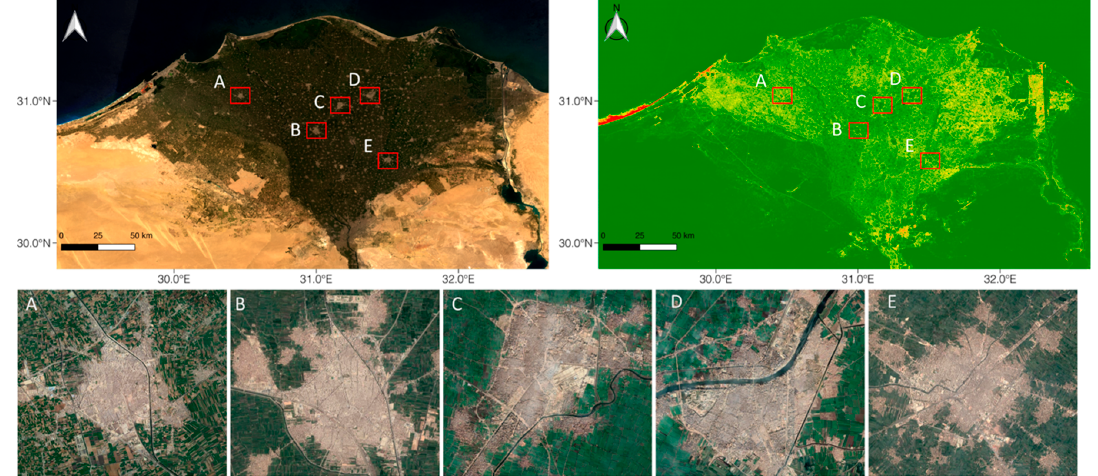
Figure 9. The Landsat-8 true color composite image and corresponding impervious surface map in the year 2019 for the Nile Delta region with its unmarked towns ( A – E ) shown in the high-resolution satellite images in Google Map.